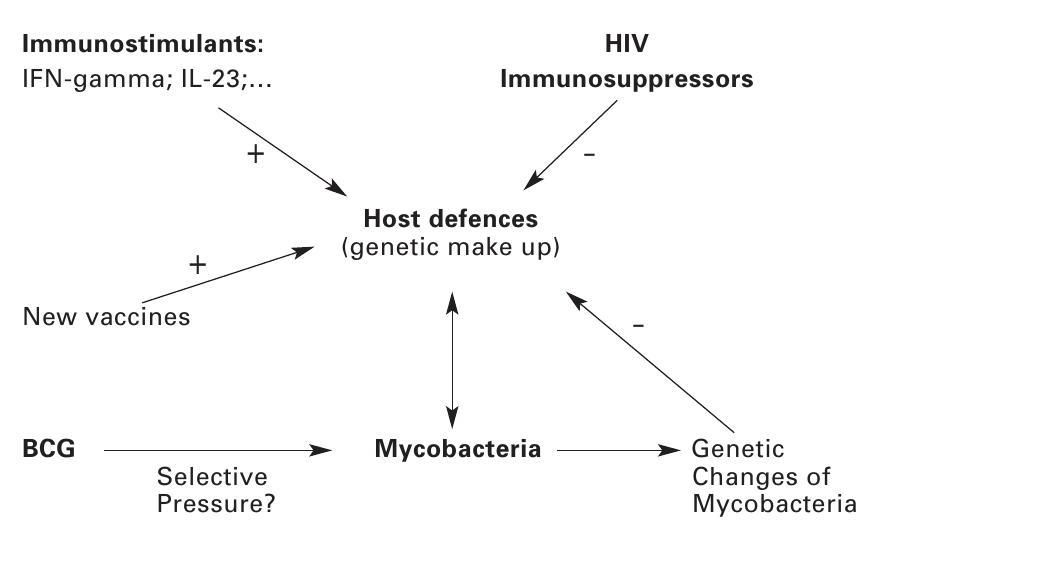
Role of dendritic cells (DCs), alveolar macrophages (AM); T lymphocytes (TL), either CD4, CD8 or Natural Killer (NK) and of B lymphocytes (BL) in defence against mycobacteria TLR-2 = Toll like re- ceptor; DC-SIGN=DC specific intracellular molecular 3 grabbing non-integrin; ROI = reactive oxygen in- termediates; NO =